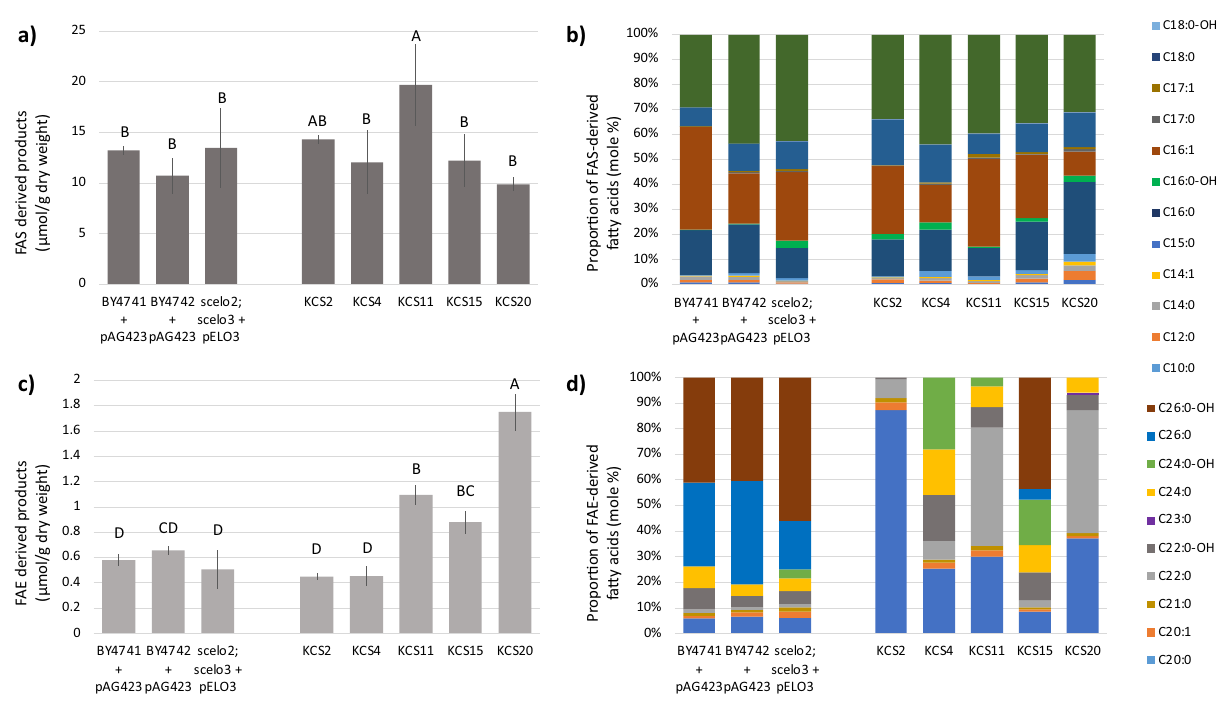
Figure 4. Fatty acid profiles generated by the scelo2; scelo3 double mutant strains complemented by the expression of Zm KCS isozymes. ( a ) Yield of FAS-derived products. ( b ) Proportion of individual FAS-derived products. ( c ) Yield of FAE-derived products. ( d ) Proportion of FAE-derived products. See “Methods” section for details on data gathering and analysis. Fatty acid profiles were determined by GC–FID analysis of FAMEs. Error bars represent standard error from 3 replicates, and different letters above data-bars indicate statistically significant differences based on the Student’s t-test ( p < 0.05).